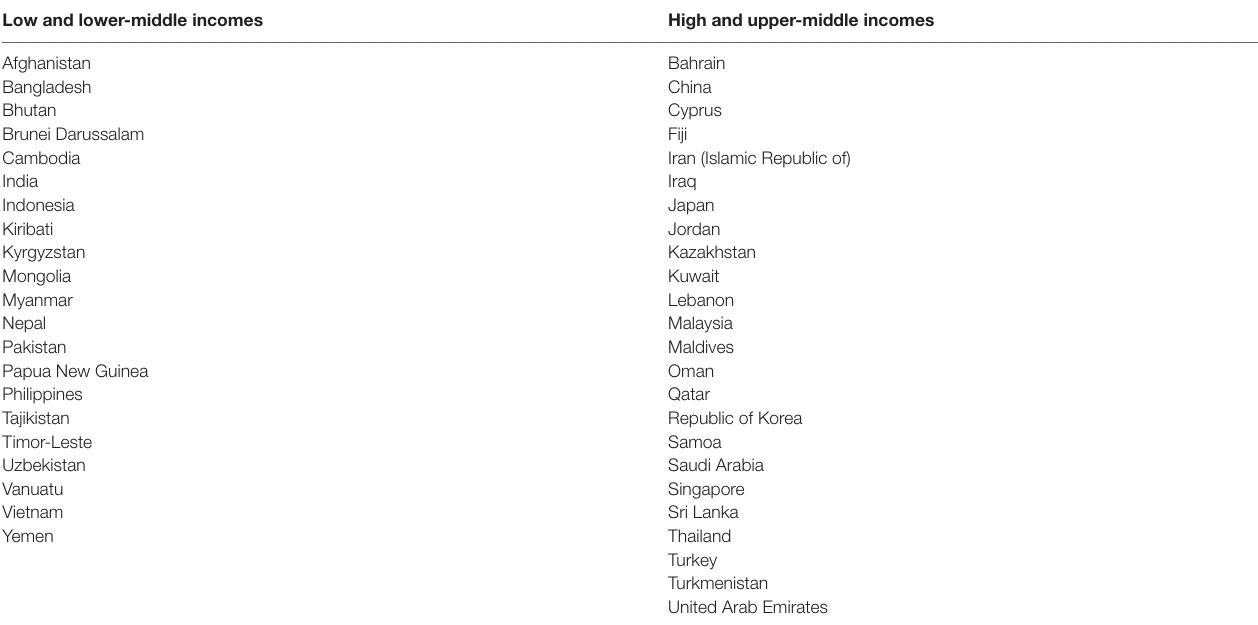
TABLE A2 | Classification of samples based on